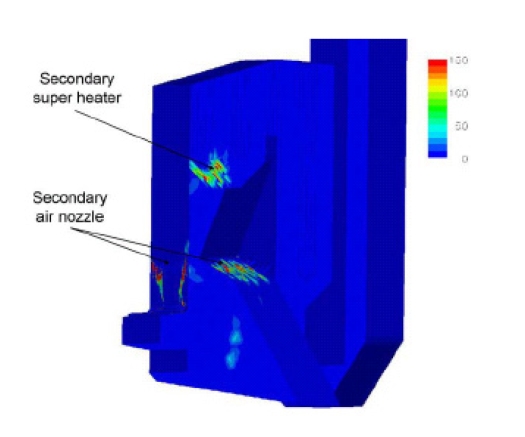
Predicted deposition mass flux in gm−2h−1 [26].